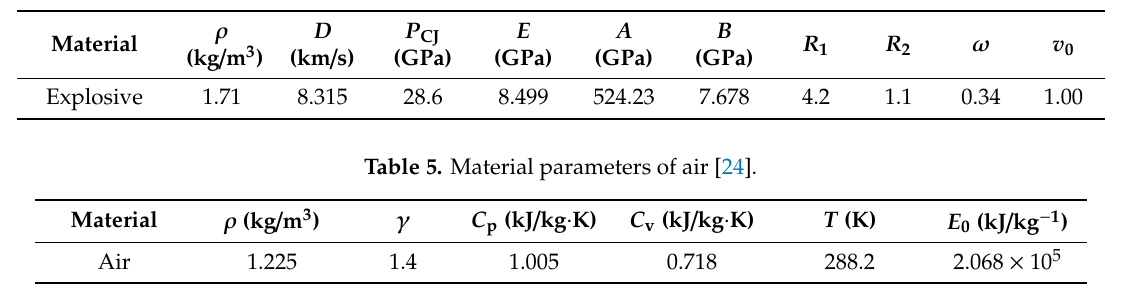
Table 4. Parameters of the 8701 explosive [24,35].